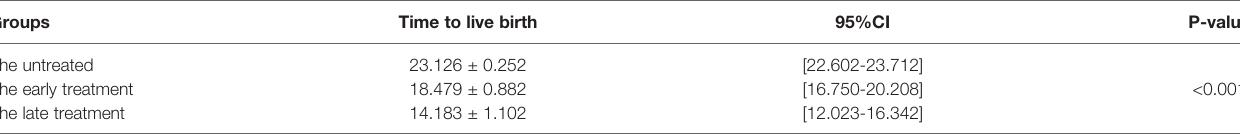
TABLE 3 | The cumulative live birth rate per Kaplan – Meier